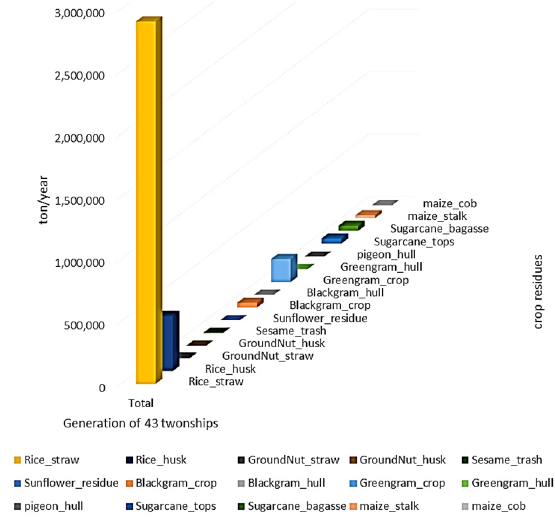
Figure 3. Crop Residue Generation from 43 Townships.